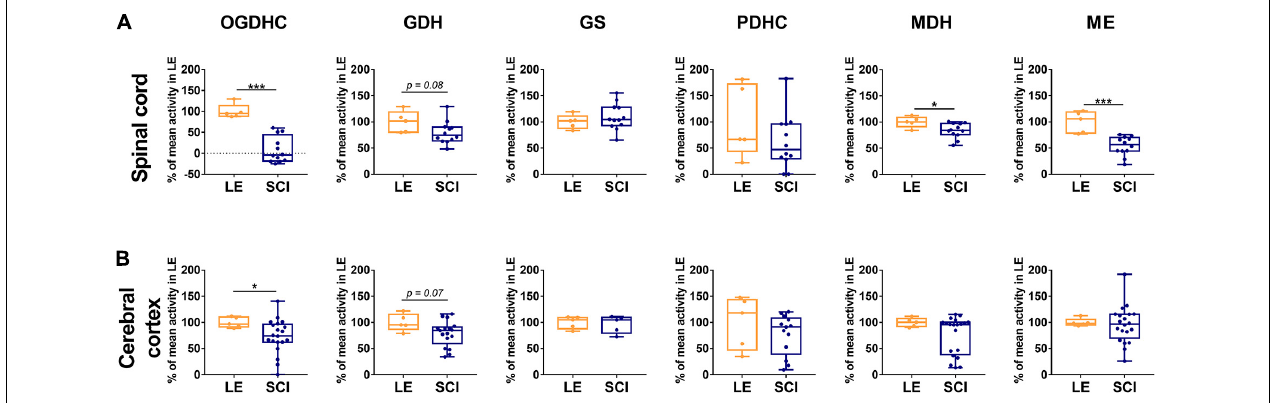
FIGURE 2 | The long-term effect of severe spinal cord injury (SCI) on the enzymatic activities in spinal cord (A) or cerebral cortex (B) , compared to those of the rats subjected to laminectomy (LE). The assayed activities are indicated in the upper part of the figure, the enzymes are indicated as in Supplementary Figure S1 . Data are expressed as percentage of the activity level in LE group. Statistical significance of differences between groups is estimated using Mann-Whitney’s test. Different p -values are shown by asterisks as described in Methods under Statistical Analysis. Number of animals analyzed in each group: LE, n = 5; SCI, n ≥